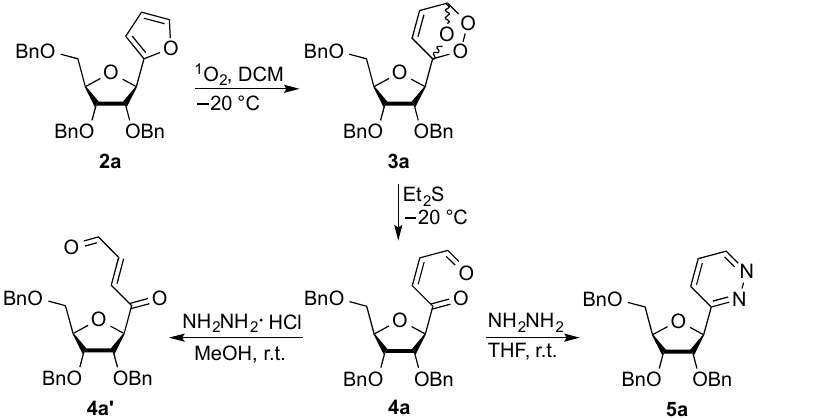
Scheme 2. Dye-sensitized photooxygenation of ribofuranosyl furan 2a , followed by reduction and hydrazine treatment.